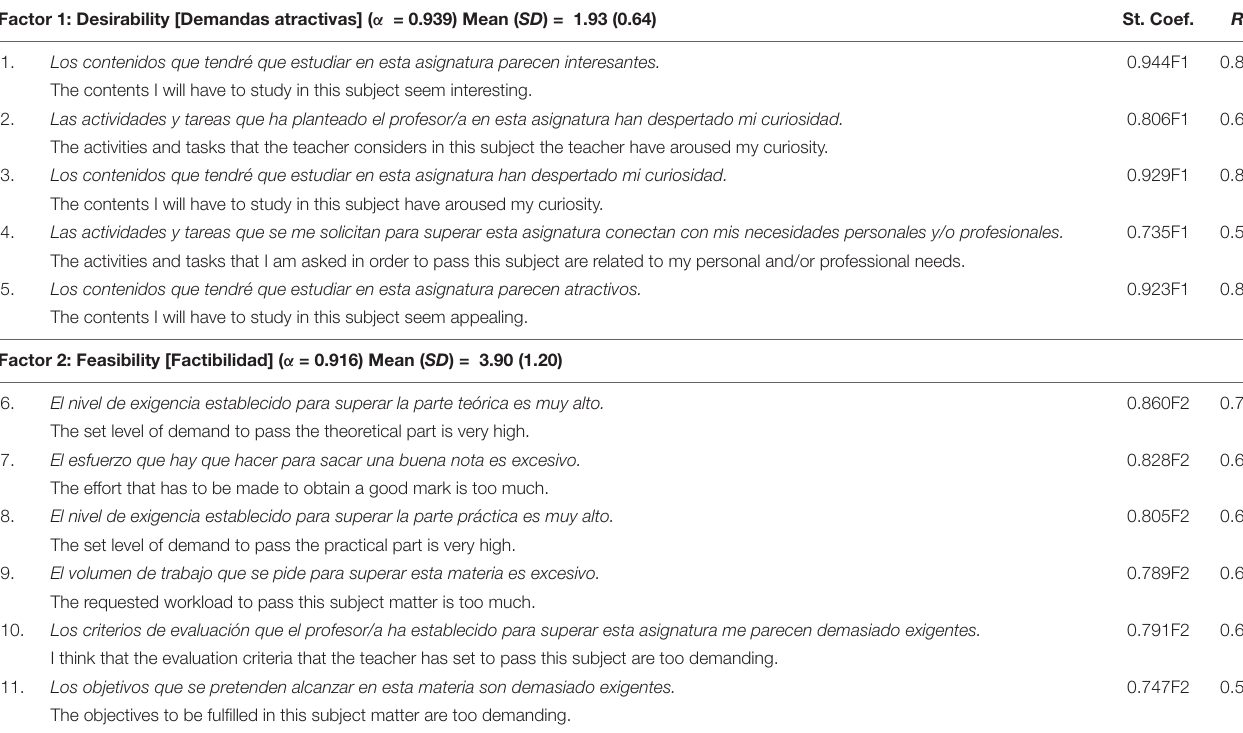
TABLE 2 | MOCSE-LDS factor structure, items’ standardized coefficients and their contribution to the corresponding factor ( R